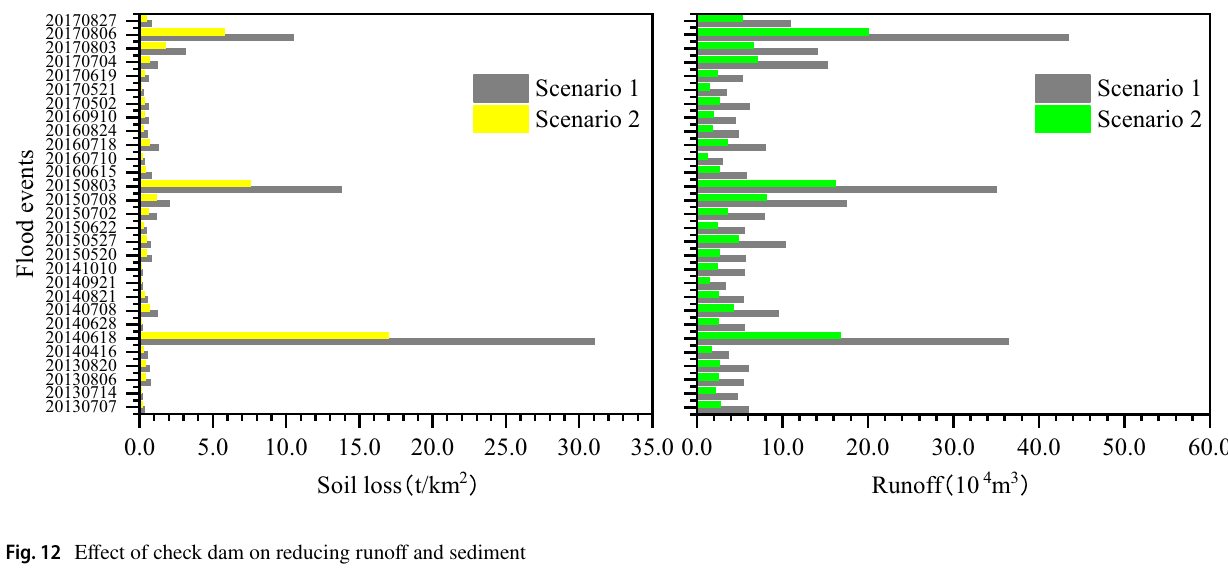
Fig. 12 Effect of check dam on reducing runoff and sediment